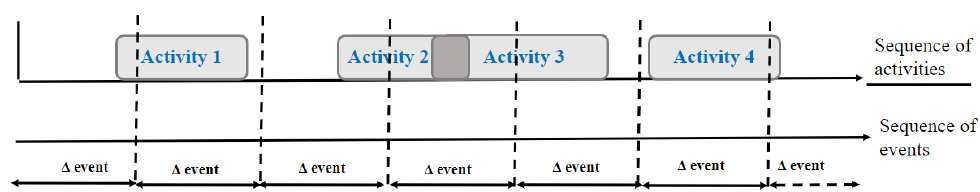
Figure 3. Sensor event window.